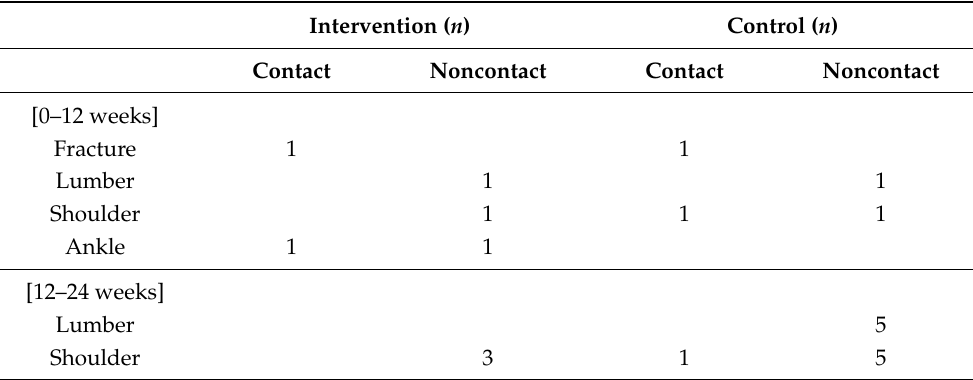
Table 3. Injury sites up to 12 weeks and from 12 to 24